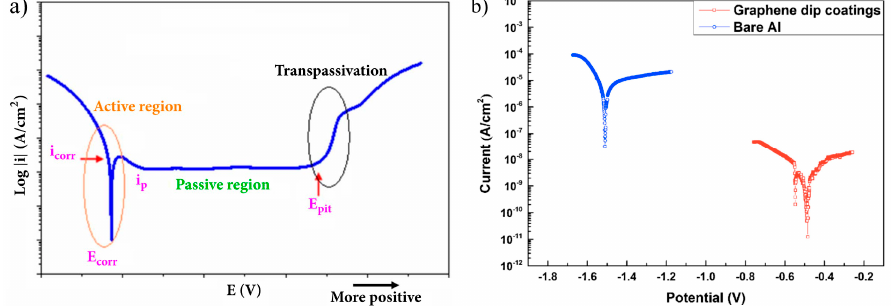
Figure 4. ( a ) Graph obtained from a potentiodynamic (PD) test showing three regions: (1) active region—indicates active corrosion, (2) passive region—indicates the formation of passive protecting film, (3) transpassivation region—indicates the initiation of passive film dissolution at high potential. Adapted with permission from ref. [65] under Creative Commons Attribution 4.0 International License; ( b ) graph obtained for graphene coating on Al substrate in 0.5 M NaCl exhibiting anti-corrosion ability of graphene. Reprinted with permission from ref. [68]. Copyright 2014 Elsevier.